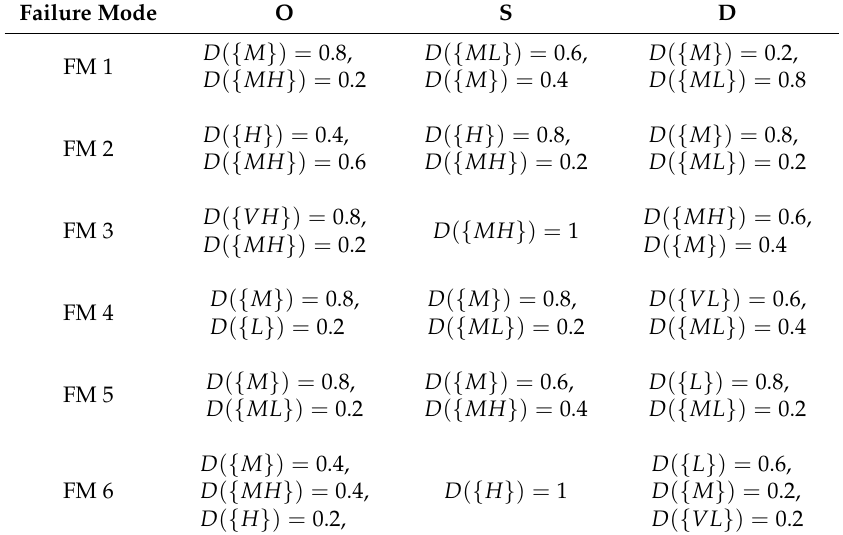
Table 8. The evaluations to failure modes in the form of D